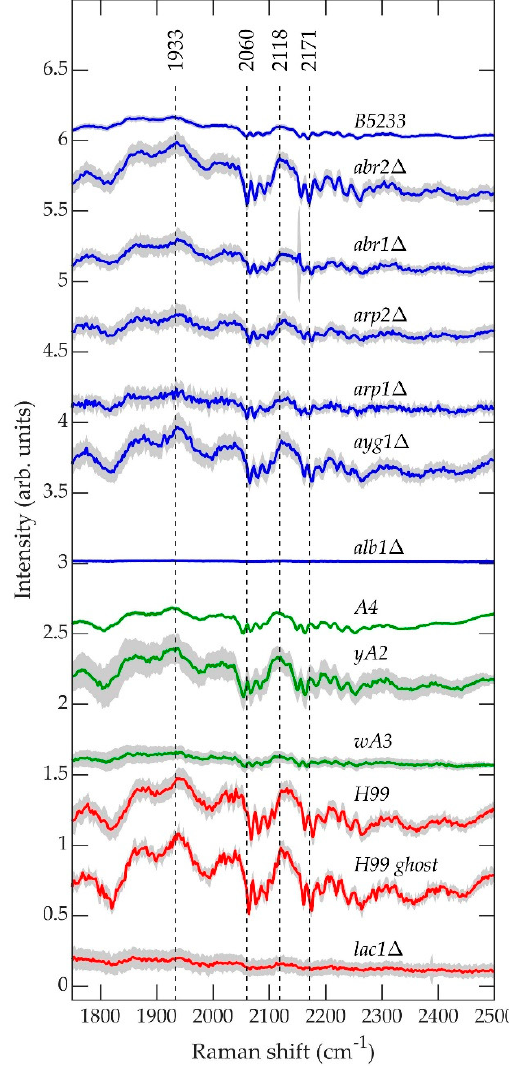
Figure 10. Average normalized background-subtracted raw spectra of A. fumigatus (blue), A. nidulans (green), and C. neoformans (red) strains in the range 1750–2500 cm − 1 .